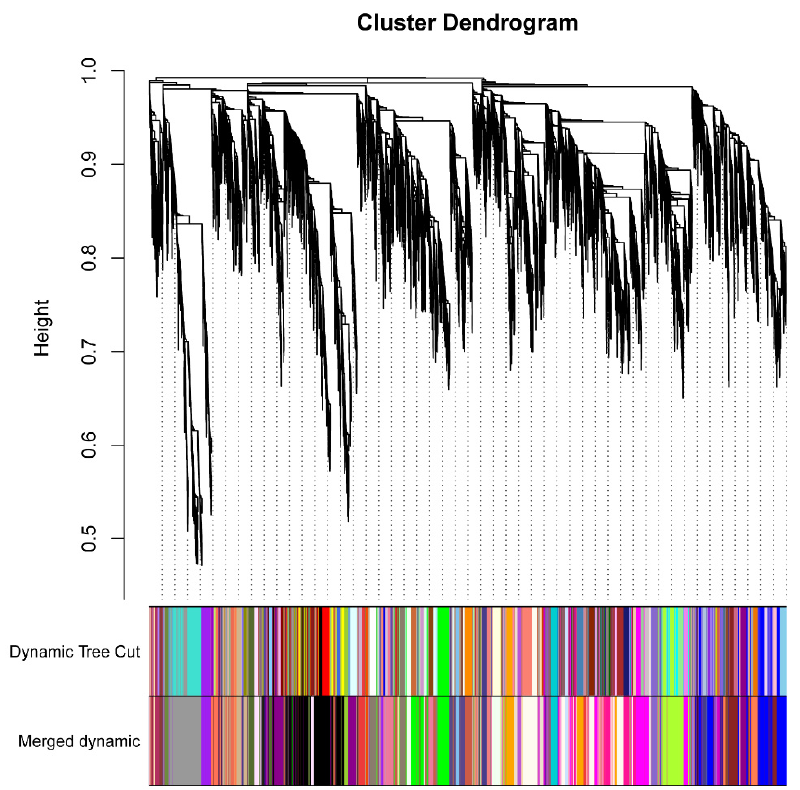
Figure 7. Gene cluster dendrograms and module detection. From the top to the bottom are clustering dendrograms of genes based on the topological overlap, gene modules of dynamic tree cut, gene modules of merged dynamic tree cut, created by merging similar modules.